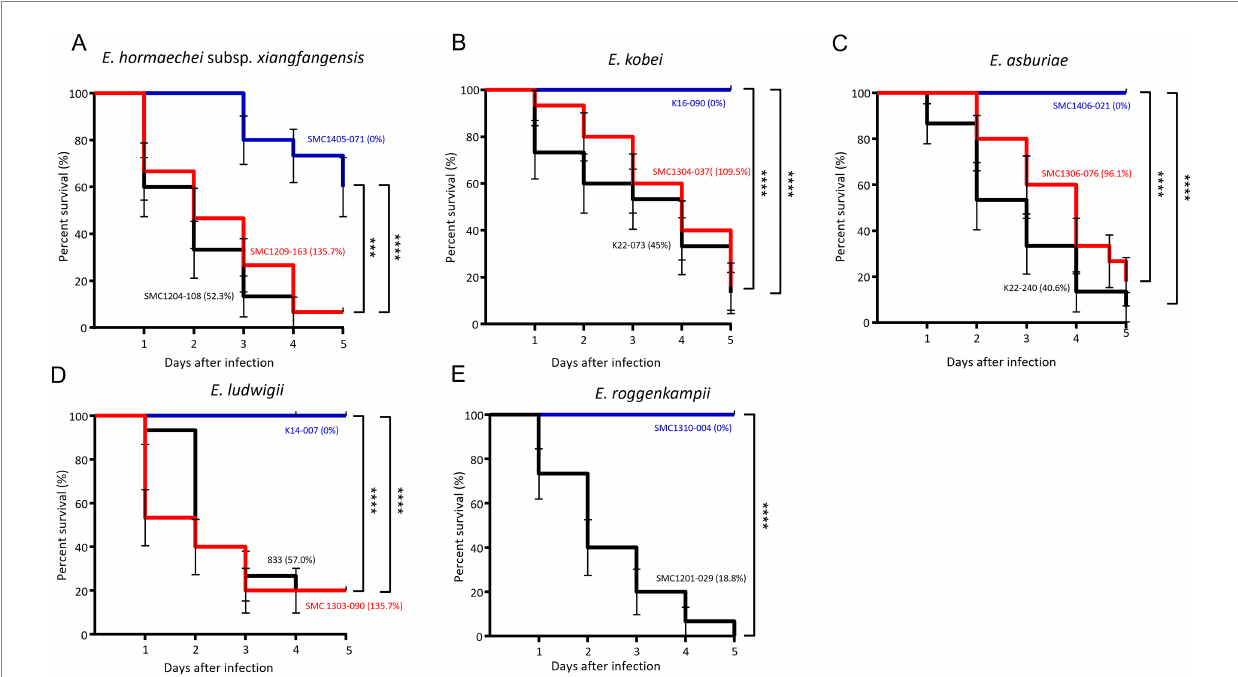
FIGURE 4 Results of Galleria mellonella larvae infection experiments. Survival of larvae infected with three isolates from each of the five Enterobacter cloacae complex (ECC) species, except Enterobacter roggenkampii . Enterobacter hormaechei subsp. xianfangensis (A) , Enterobacter kobei (B) , Enterobacter asburiae (C) , Enterobacter ludwigii (D) , and Enterobacter roggenkampii species (E) . Three isolates from each species were selected for low (blue line), intermediate (black line), and high (red line) survival rates in the serum bactericidal assay. For E. roggenkampii , with no isolates showing high survival rate in serum bactericidal assay, two isolates were included. The percentages in parentheses represent the survival rates in the serum bactericidal assay. Five larvae were evaluated per isolate, and results were obtained from three independent experiments. p < 0.001; **** p <